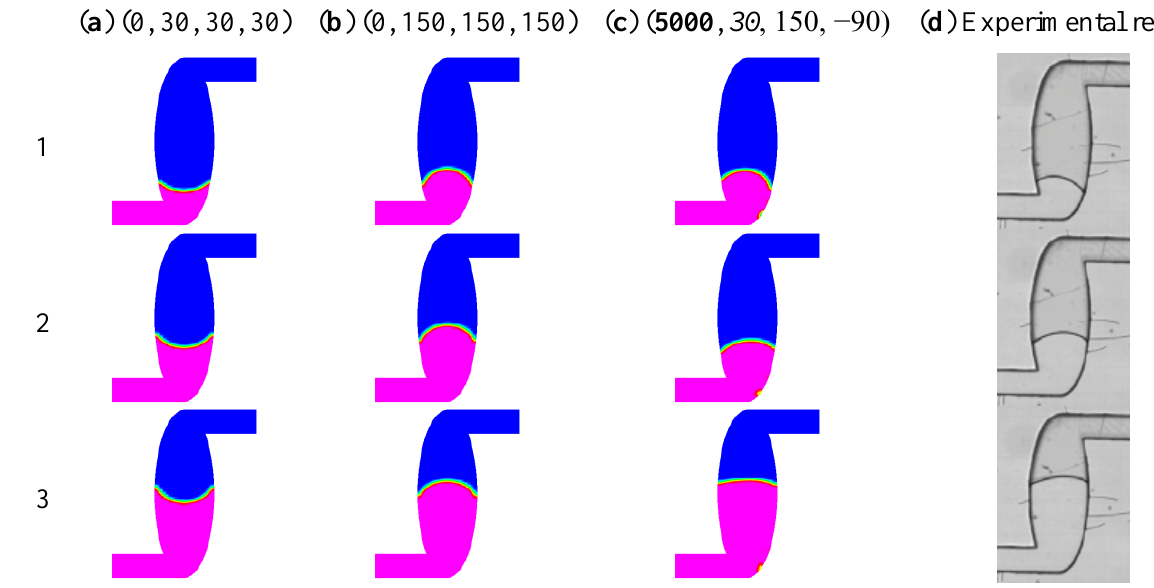
Figure 12. Computational results corresponding to experimental measurements. ( a ) K is 0° s/m, θ is 30°, θ is 30° and θ is 30°; ( b ) K is 0° s/m, θ is 150°, θ is 150° and s lc uc s lc θ is 150°; ( c ) K is 5000° s/m, θ is 30°, θ is −90° and θ is 150°; ( d ) photographs of a uc s lc uc microchannel device showing liquid filling